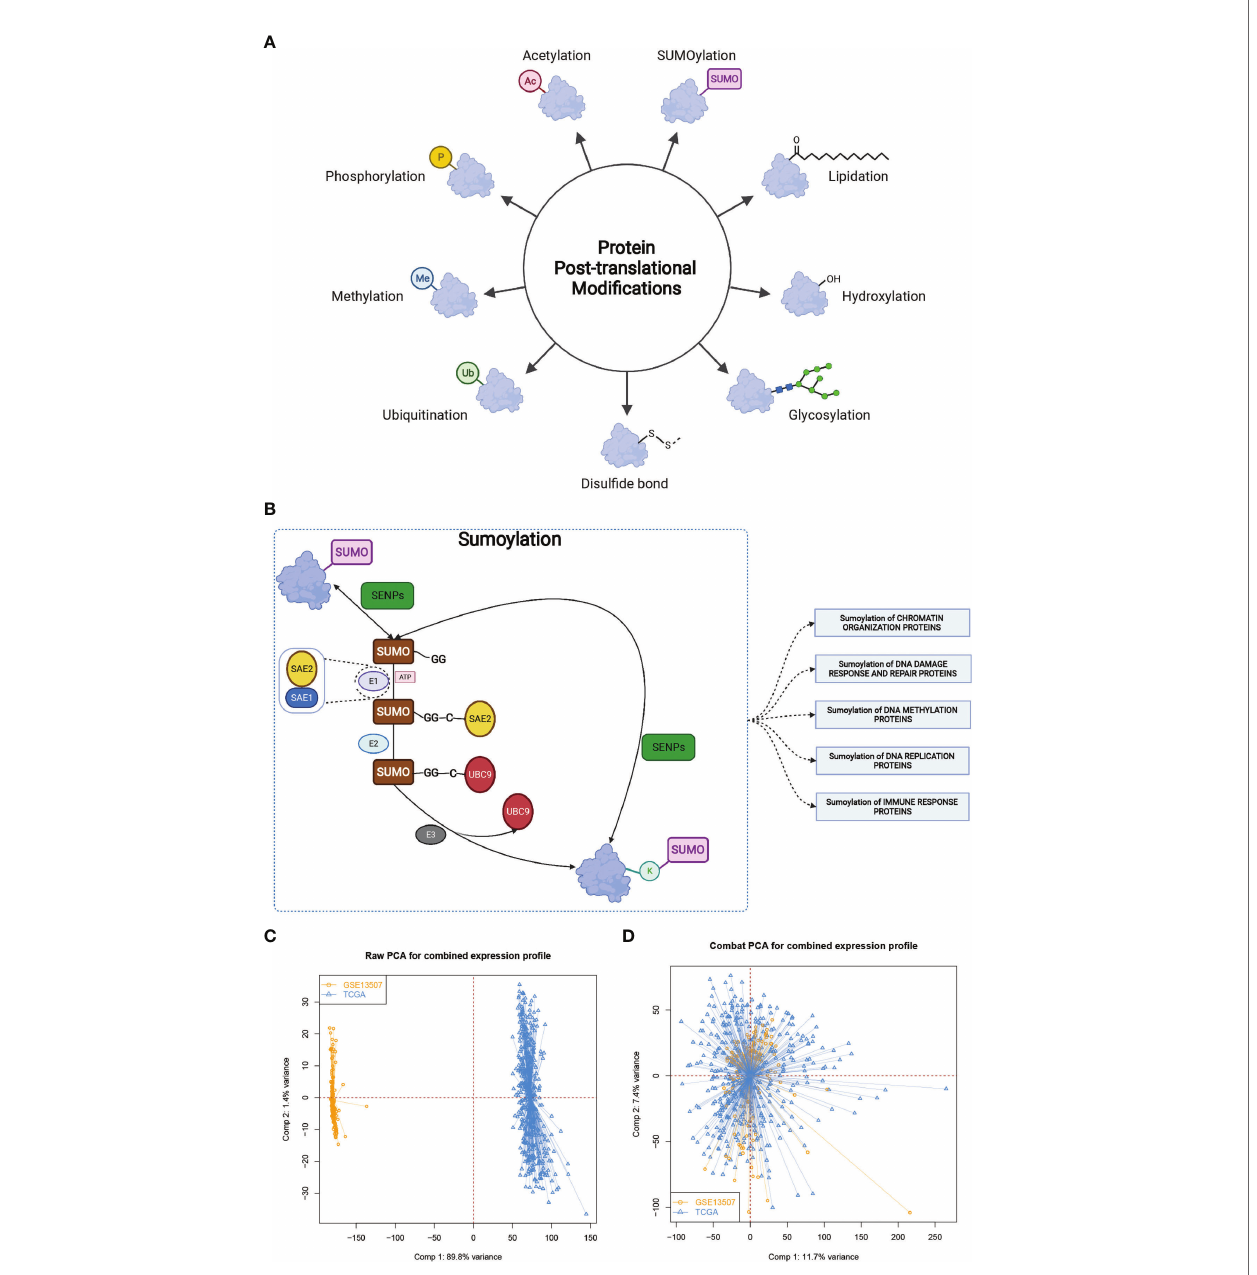
FIGURE 1 | The landscape of SUMOylation and the combination of two different datasets. (A, B) Various types of protein post-translational modi fi cations and summary of SUMOylation process, SUMOylation related biological processes, and enzymes involved in these processes. (C, D) Principal component analysis for the expression pro fi les of common genes before and after combination of GSE13507 and TCGA-BLCA cohort. Before processing, two subgroups without intersection were identi fi ed, indicating the GSE13507 and TCGA-BLCA samples were well distinguished based on the expression pro fi les of their common genes, while the two datasets merged together well after processing. Samples from GSE13507 were marked with yellow and samples from TCGA-BLCA marked with